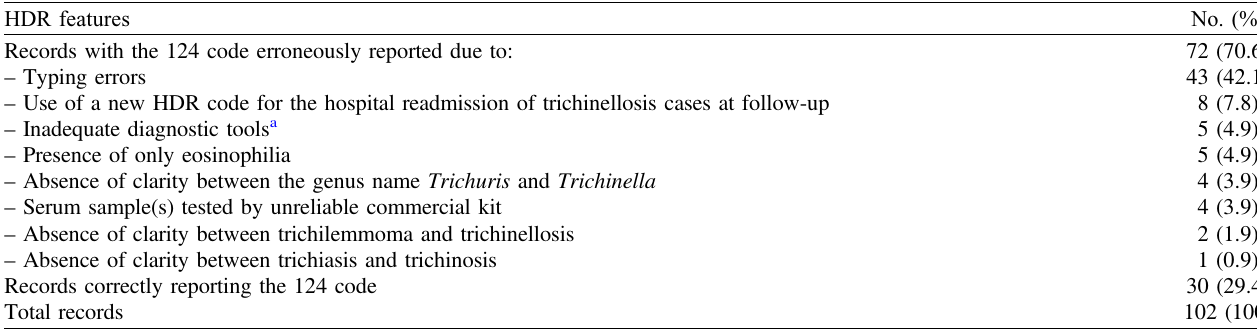
Table 1. Features of hospital discharge records (HDRs) with the 124 code (for trichinellosis) downloaded from the Italian Ministry of Health website for the period 2005 –